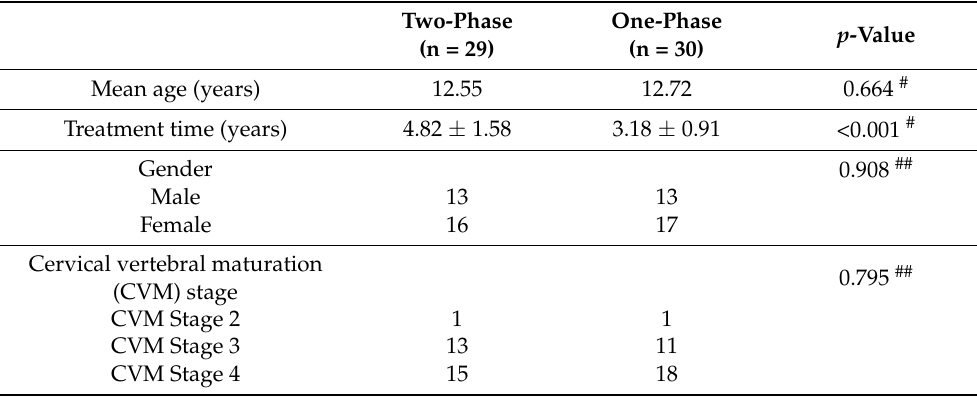
Table 2. Demographic characteristics of the study subjects.